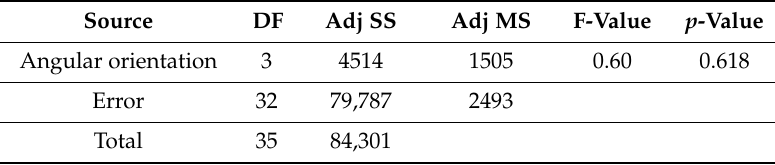
Table 9. ANOVA results for E as a function of angular orientations.